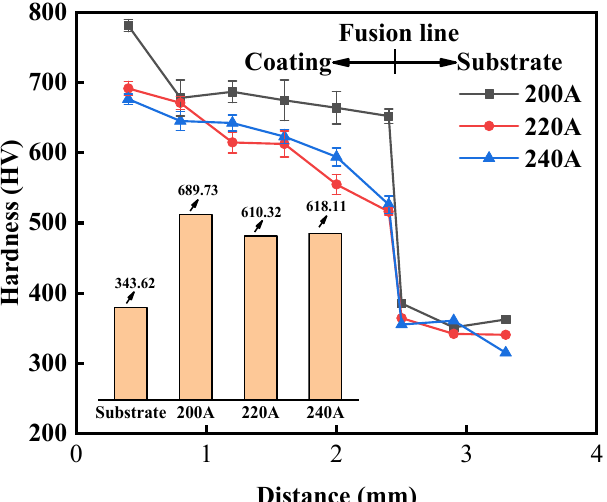
Figure 5. Cross-sectional microhardness of the FeCrMnCuNiSi 1 high-entropy alloy coatings with different currents.